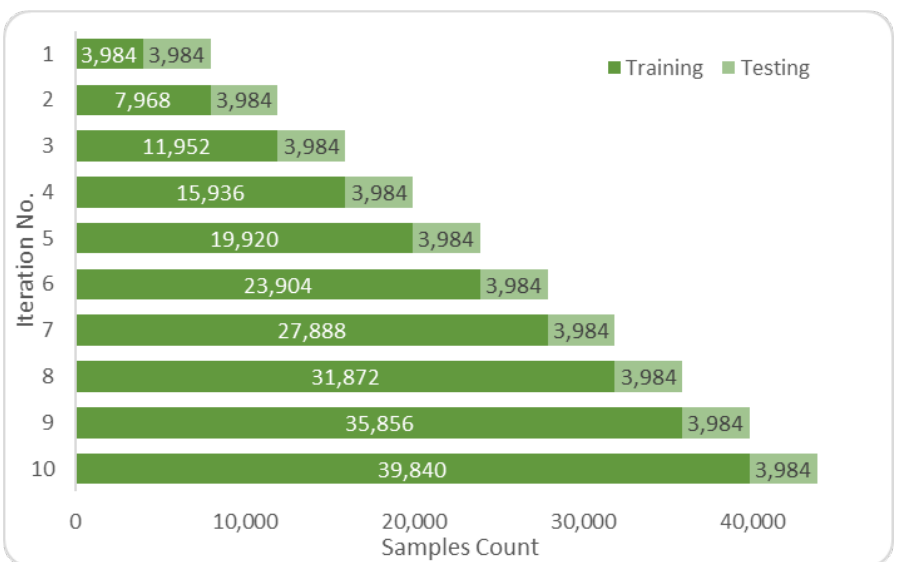
Figure 9. Training vs. testing in timeseries split cross-validation n =10 for the Beijing dataset.